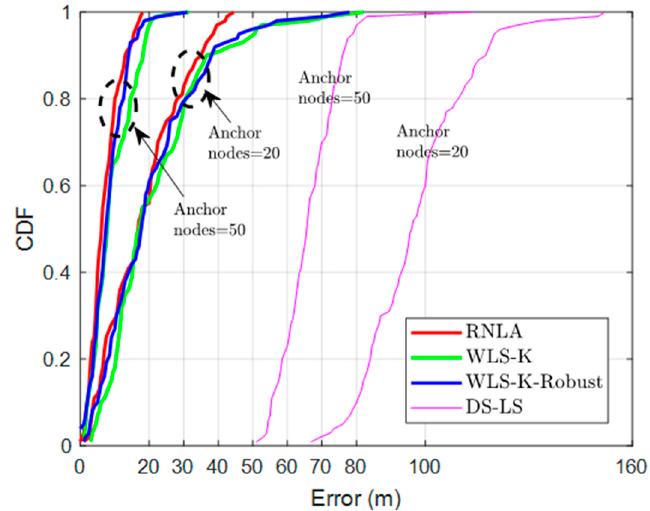
Figure 6. Cummulative distribution function (CDF) of different methods.